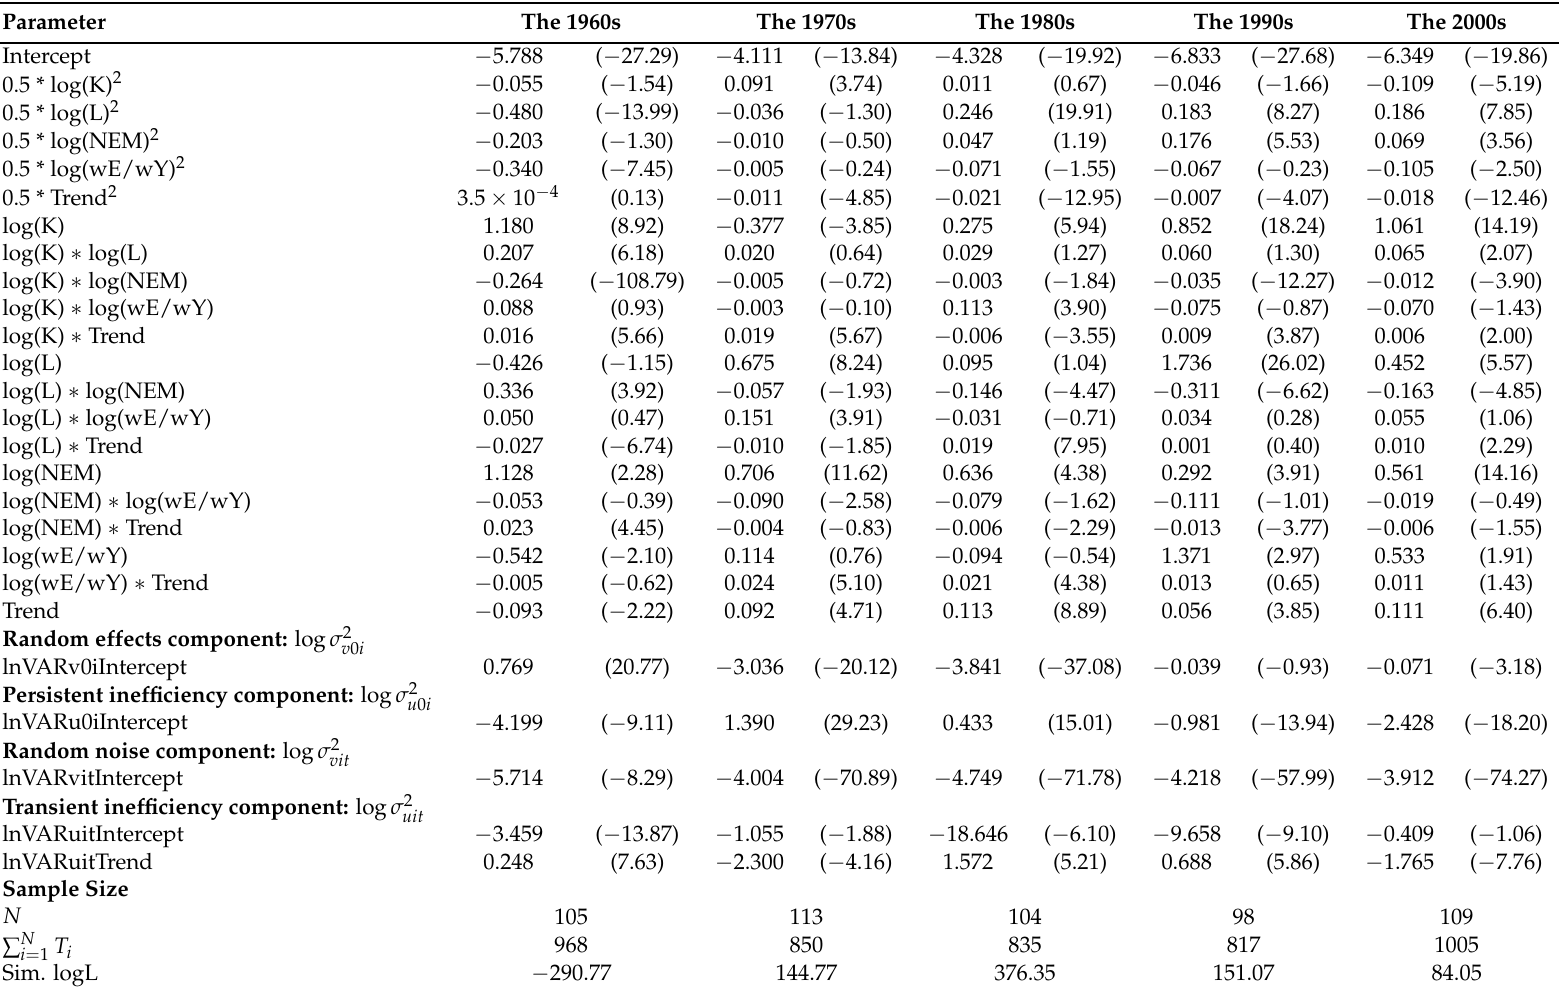
Table 4. Model 3 as in Equation (10). Dependent variable is − log E . z -values in